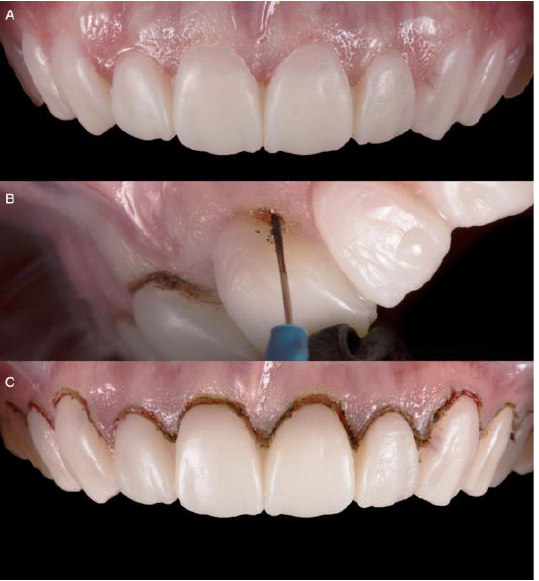
Figure 3. Diagnostic overlay and tissue recontour: ( A ) Placement of the diagnostic overlay intra- orally; ( B ) Gingivoplasty with an electrosurgical unit; ( C ) Finishing the contouring with the laser.